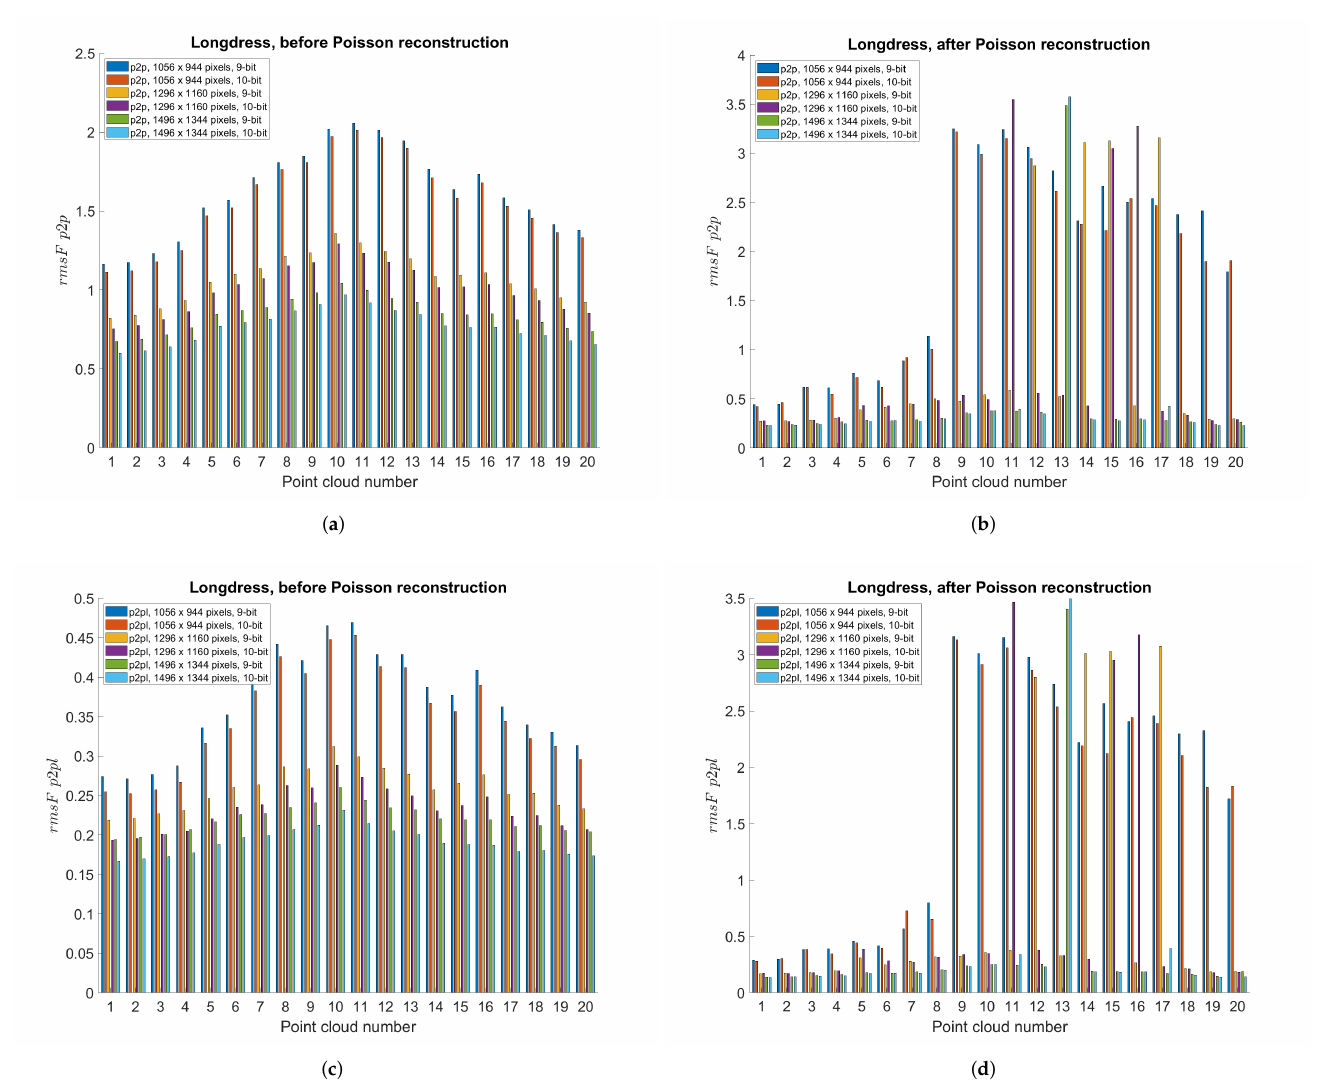
Figure 16. Objective measure per point cloud, using Miller projection with 9-bit depth and 10-bit depth: ( a ) before Poisson reconstruction, point-to-point measure; ( b ) after Poisson reconstruction, point-to-point measure; ( c ) before Poisson reconstruction, point-to-plane measure; ( d ) after Poisson reconstruction, point-to-plane